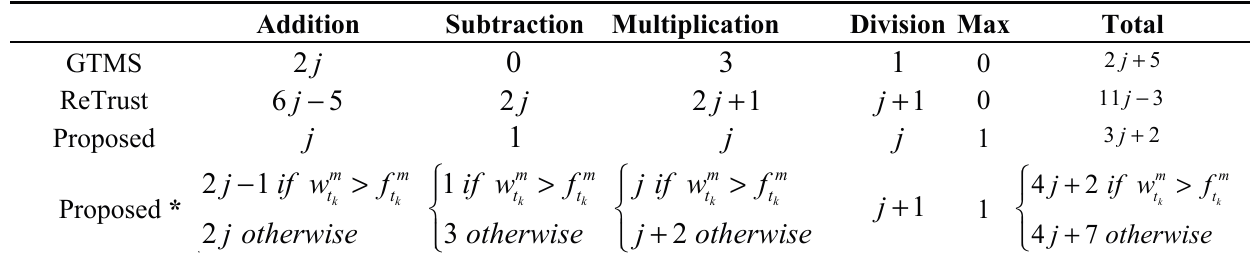
Table A2. Computational overhead in terms of number of operations in each trust estimation